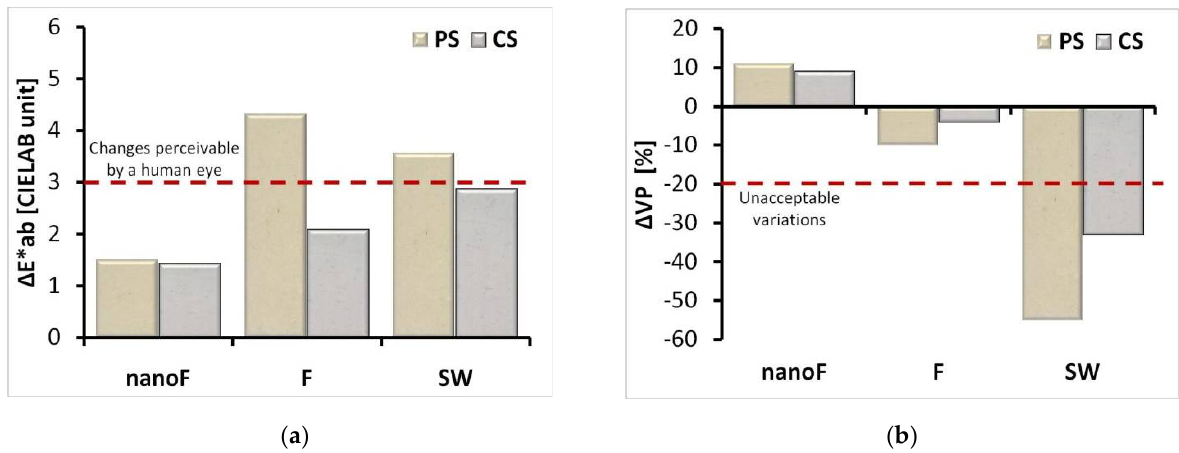
Figure 2. ( a ) Color changes (ΔE* ab ) and ( b ) variations in water vapor permeability before and after the products’ application. The columns’ colors reproduce the appearance of the stone.